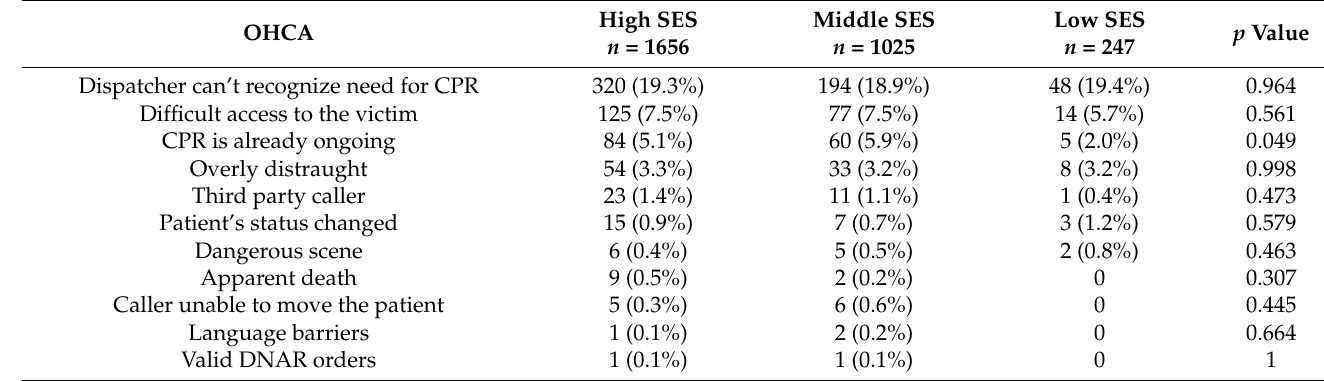
High SES Middle SES Low SES p Value n = 1656 n = 1025 n = 247